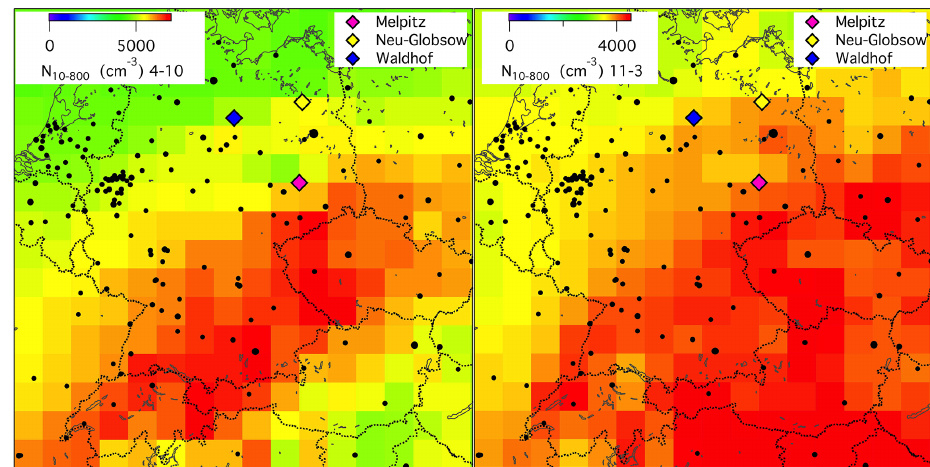
Figure 1. Maps of particle number concentration N 10 − 800 (cm − 3 ) extrapolated under 1000m of height along 5d back trajectories from hourly data at the four stations from 2009 to 2018; left: months April through October; right: months November through March. The GUAN stations are marked with colored diamonds. The Collmberg station lies 30km southeast of Melpitz station. Here and in the following maps the black dots represent cities larger than 100000 inhabitants, with the size of the dots being proportional to the number of inhabitants.